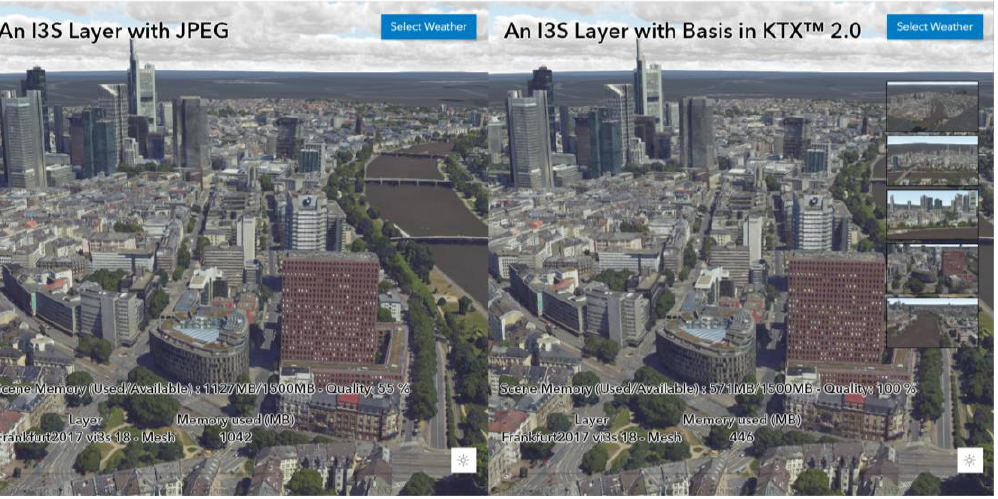
Figure 4 . Figure showing evolution of OGC I3S V1.2. An ArcGIS JSAPI based side-by side compare application, https://tamrat- b.github.io/i3sBasisKTX20, demonstrating OGC I3S 1.2 client-side memory reduction improvements. The app has various bookmarks where on average I3S 1.2 shows over 60% client-side memory savings when the input I3S layer is JPEG vs Basis Universal SuperCompressed texture in KTX™2.0